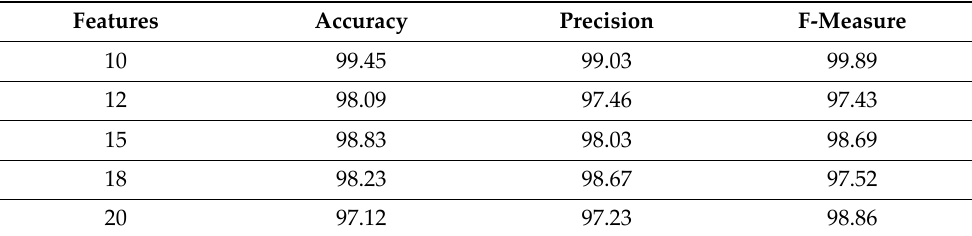
Table 12. Observations of the PSO algorithm with different feature